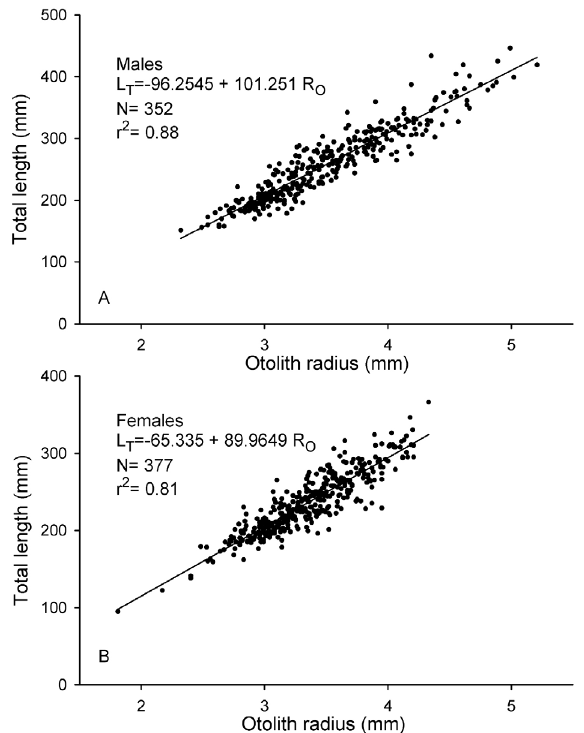
Fig . 6. – relationship between total length at capture and otolith radius for male and female toadfish sampled in the Bay of Cádiz between March 1999 and March